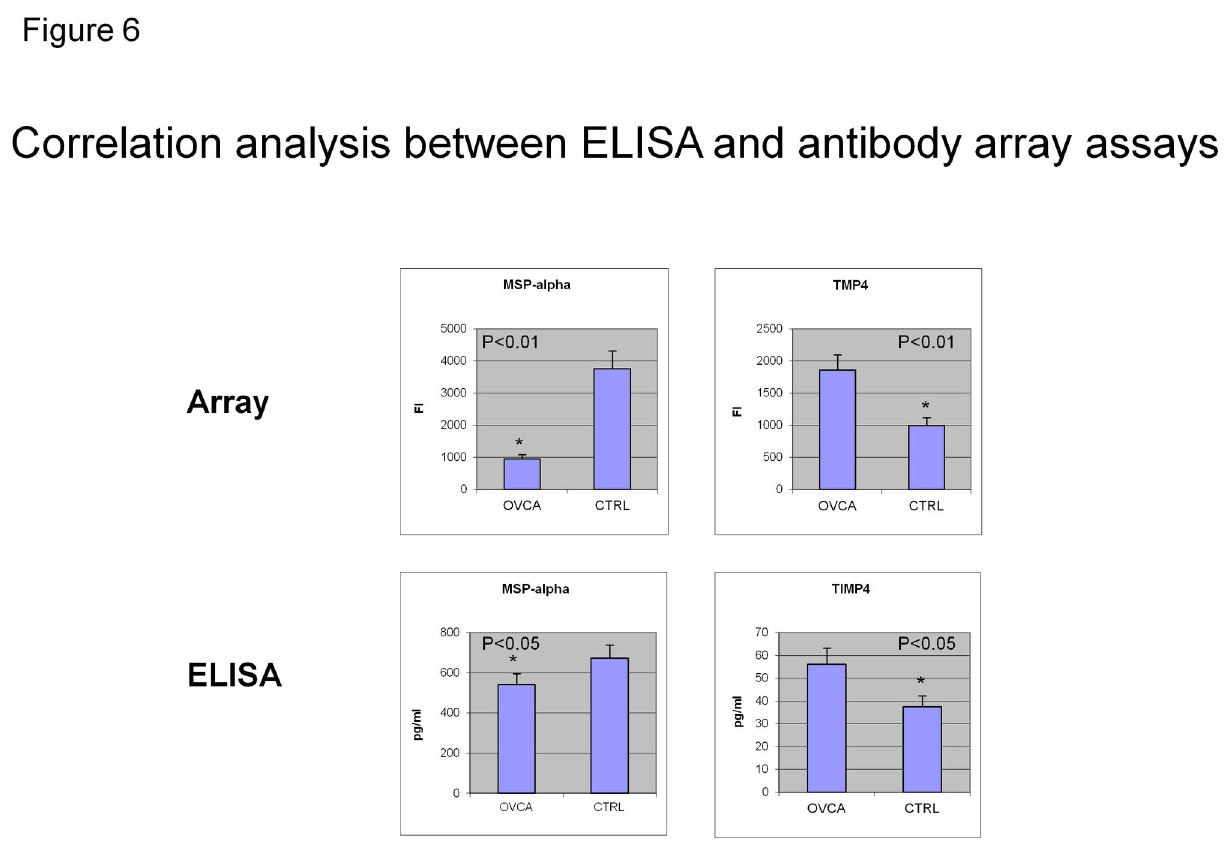
Figure 6. Correlation analysis between ELISA and antibody array assays. Levels of two protein markers (MSP-alpha and TIMP-4) identified as being differentially expressed in ovarian cancer samples using antibody arrays were confirmed with ELISA. The antibody array data were completely concordant with the ELISA data in classifying sera from ovarian cancer patients and healthy controls. Antibody array data are shown as median array signal intensity (FI), and ELISA data are shown as mean protein concentration